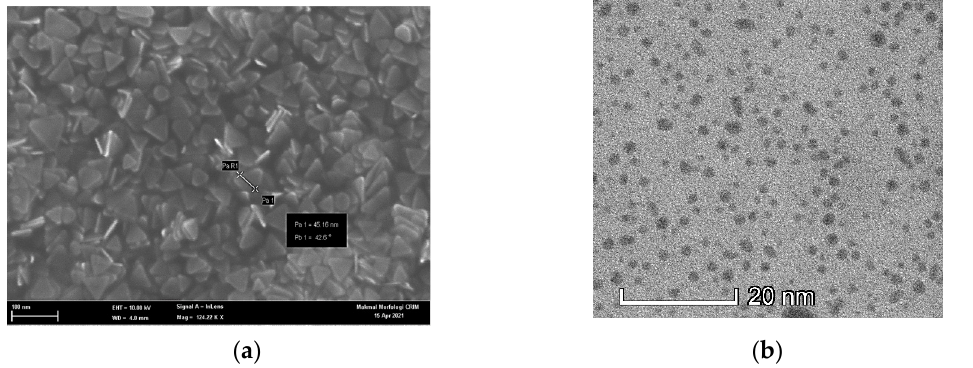
Figure 7. Morphology of sensing material with the analyte ( a ) FESEM of triangular AgNPs and ( b ) TEM of